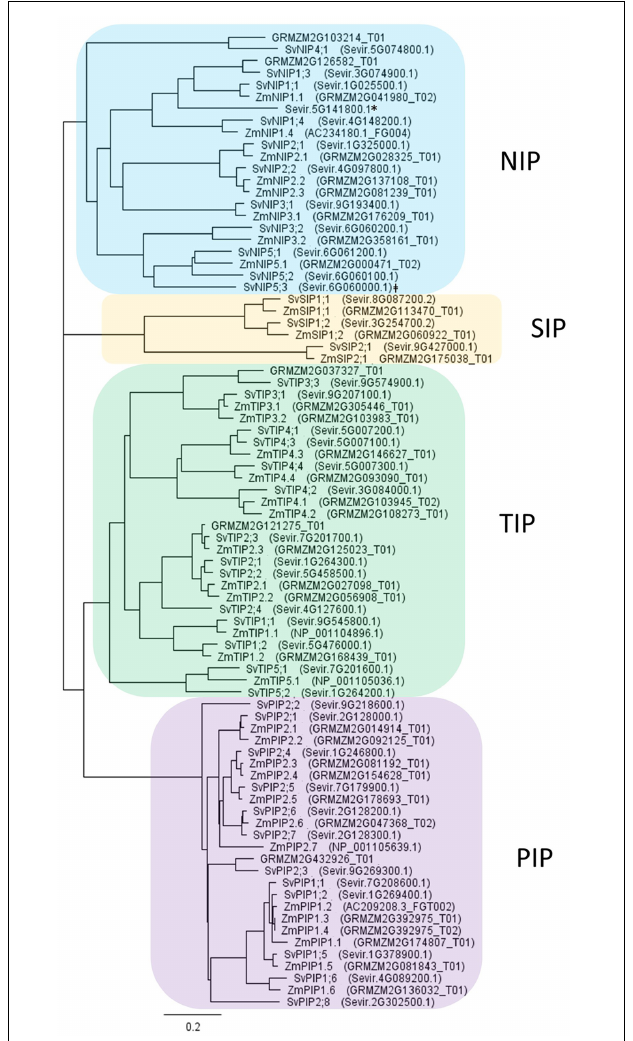
FIGURE 1 | Phylogenetic tree based on protein sequences of aquaporins from Setaria viridis and Zea mays . S. viridis aquaporins were identified in the genome via HMMER search using aquaporins sequences from Arabidopsis , barley, maize, and rice. Maize aquaporins were included in the phylogenetic tree for ease of interpretation. The addition of aquaporin sequences from other grasses did not change the groupings. Tree was generated by neighbor-joining method using the Geneious Tree Builder program, Geneious 9.0.2. The scale bar indicates the evolutionary distance, expressed as changes per amino acid residue. Aquaporins can be grouped into four subfamilies: PIPs (plasma membrane intrinsic proteins), TIPs (tonoplast intrinsic proteins), NIPs (nodulin-like intrinsic proteins), and SIPs (small basic intrinsic proteins). ∗ Sevir.5G141800.1 protein sequence is truncated, 112 amino acids in length. ‡ SvNIP5;3 (Sevir.6G06000.1) may have a related pseudogene